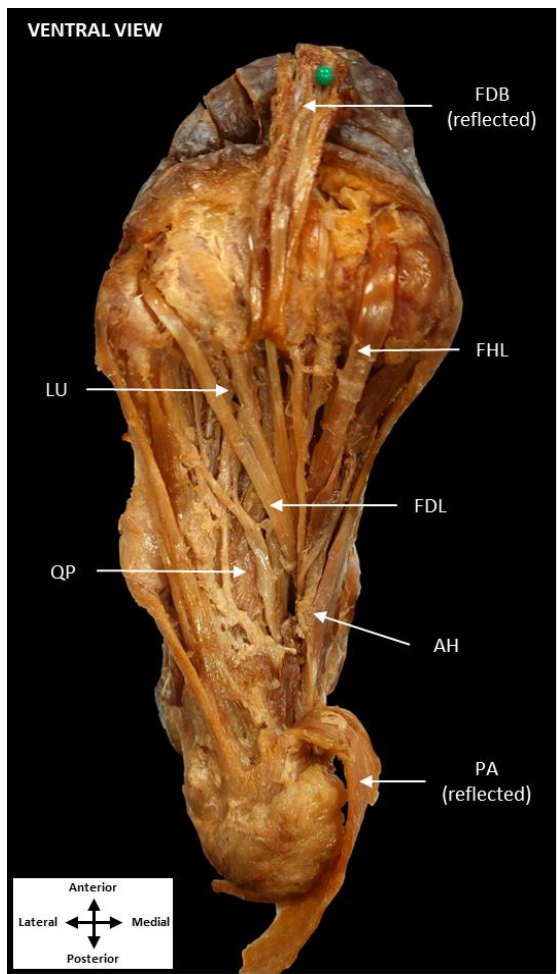
Figure 1. Dissection of the plantar surface of the foot. Dissection of the medial and central compart- ments of the plantar foot showing the QP diving deep to the FDL. (Plantar aponeurosis: PA, flexor digitorum brevis: FDB, abductor hallucis: AH, flexor digitorum longus: FDL, flexor hallucis longus: FHL, lumbrical muscles: LU, quadratus plantae: